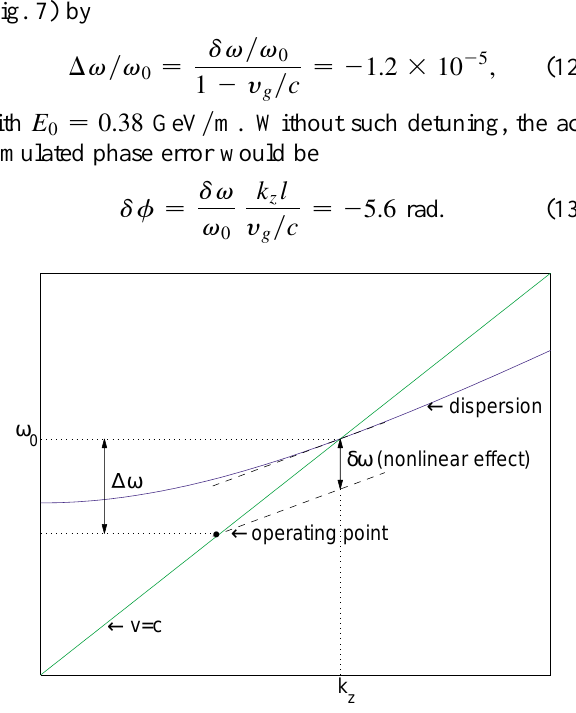
FIG. 6. A section of a parallel PBGFA bundle. FIG. 7. (Color) Frequency detuning due to nonlinear